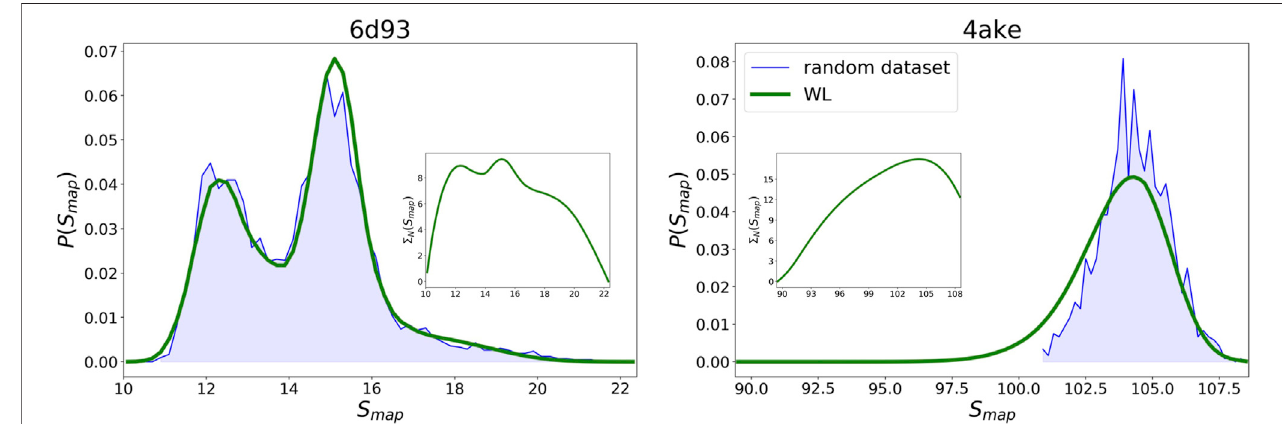
FIGURE 9 | Comparison between the probability densities P ( S map ) for the two systems estimated via the Wang – Landau algorithm enhanced by the DGNs (green lines) and the distributions generated by a random sampling of mappings (blue areas). In inset, the logarithm of the WL density of states, Σ ( S map ) , is reported, after a scaling that assigns to the Σ of the most scarcely populated bin the value of zero. All values of S map are in